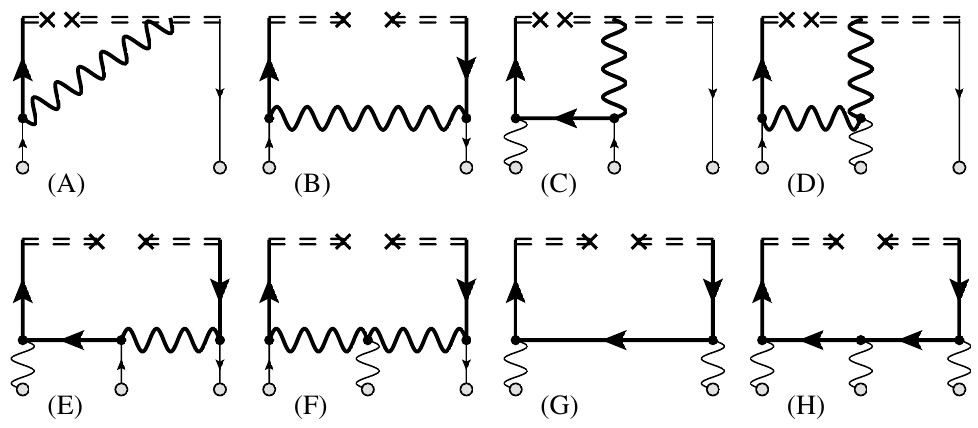
Figure 1 . Diagrams contributing to the NLO effective operator at twist-two and twist-three level. The dashed lines show the half-infinite Wilson lines. The mirror diagrams to (A, C, D, E) should be